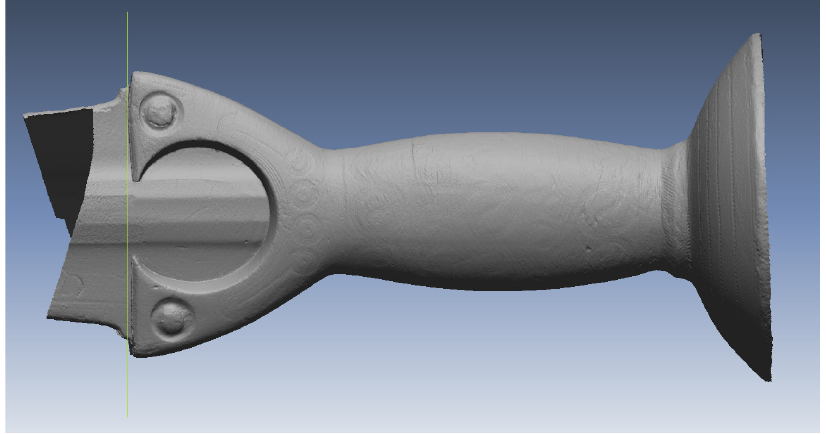
Figure 2. Placement of the z plane.